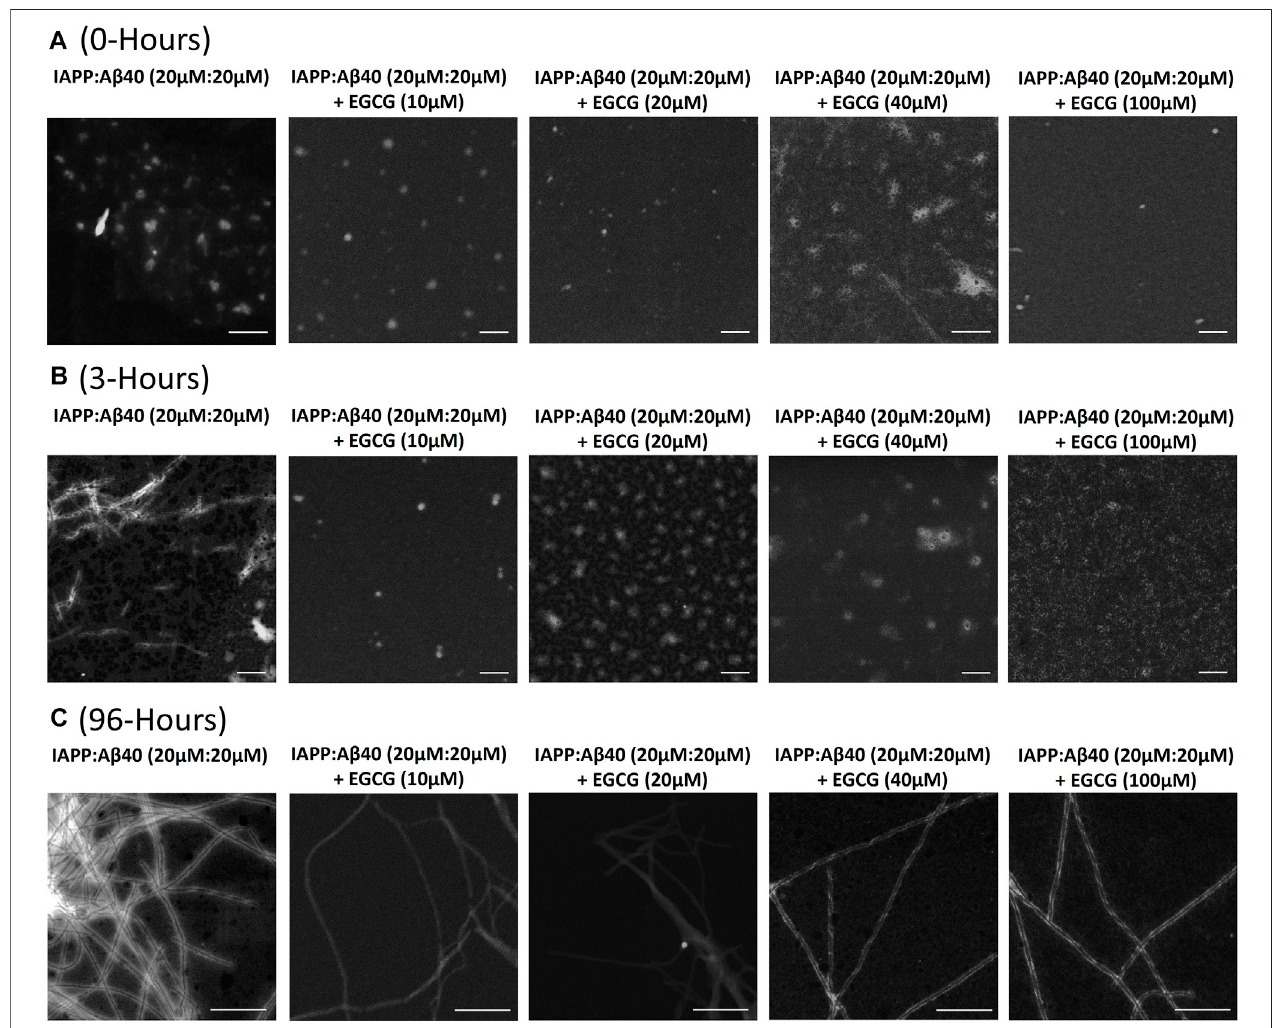
FIGURE 7 | Morphological characterization using scanning transmission electron microscopy (STEM) of (A) 0-Hour, (B) 3-Hours and (C) 96-Hours assemblies formed by the co-aggregation of equimolar IAPP-A β 40 (20 µM: 20 µM) in the absence and presence of increasing EGCG concentrations (10 – 100 µM). All scale bars represent 200